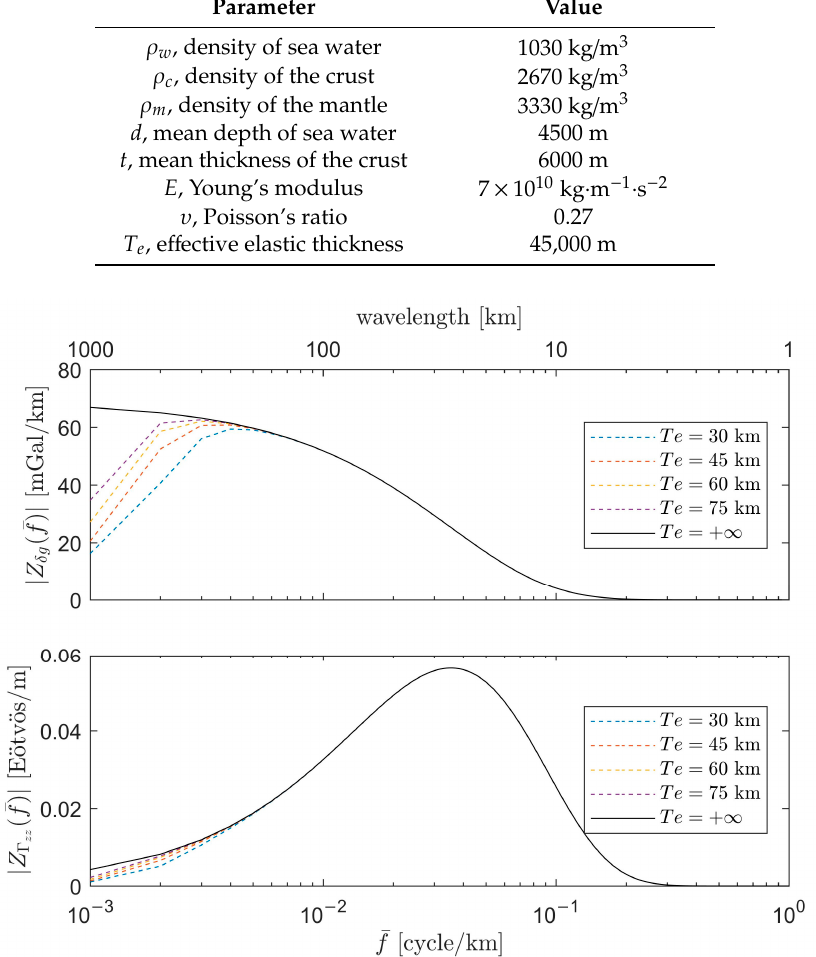
Figure 1. ( top ) The theoretical gravitational admittance; ( bottom ) The theoretical gravity gradient admittance. Scale at bottom in frequency and at top in wavelength. The solid curve is for the isostatically uncompensated model ( T e → + ∞ ). The dashed curves are for the regionally isostatically compensated model with respect to different effective elastic thickness of the plate T e